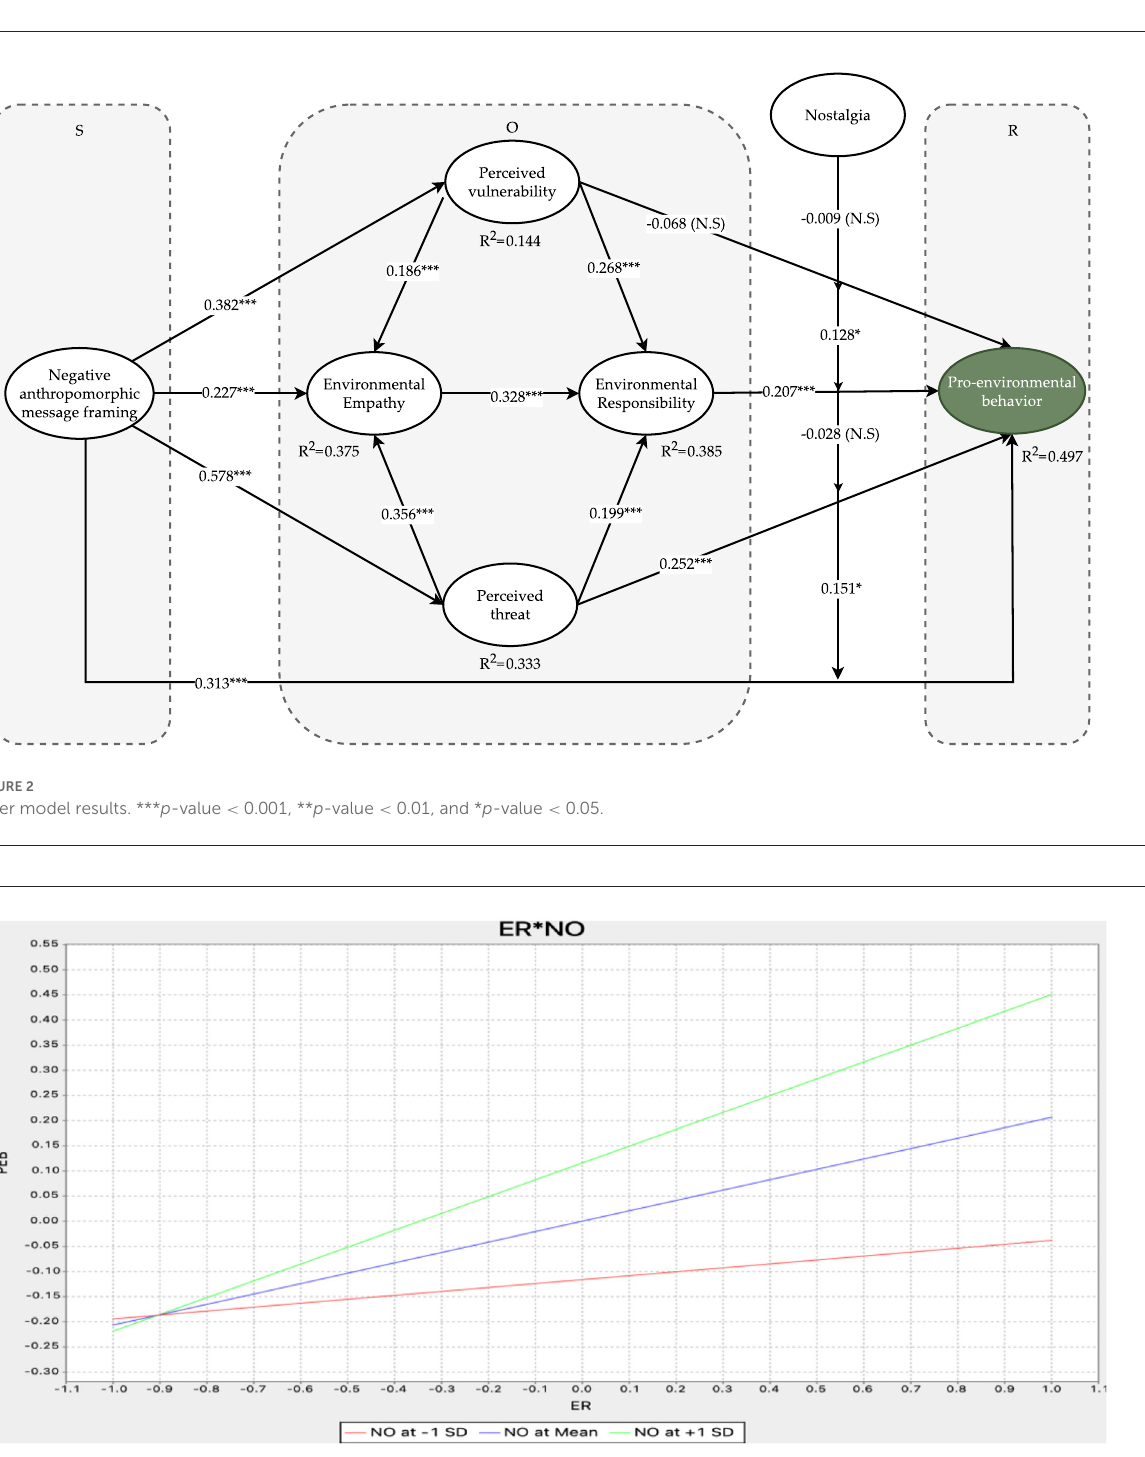
threat should not fall below 6.9% to maintain a medium level of pro-environmental behavior ( > 40%). Similarly, to achieve a high level of pro-environmental behavior (80%), at least 5.6% of